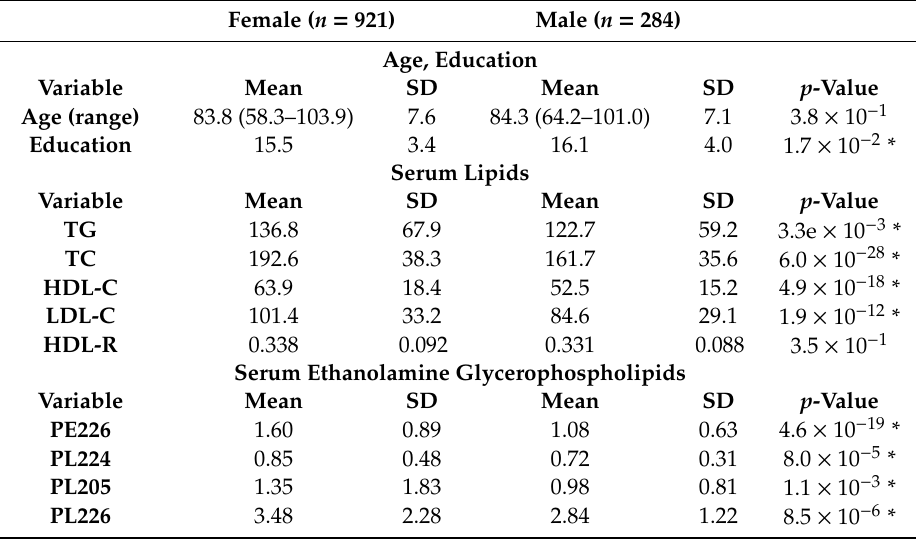
Table 1. Demographic and serum lipid summary by